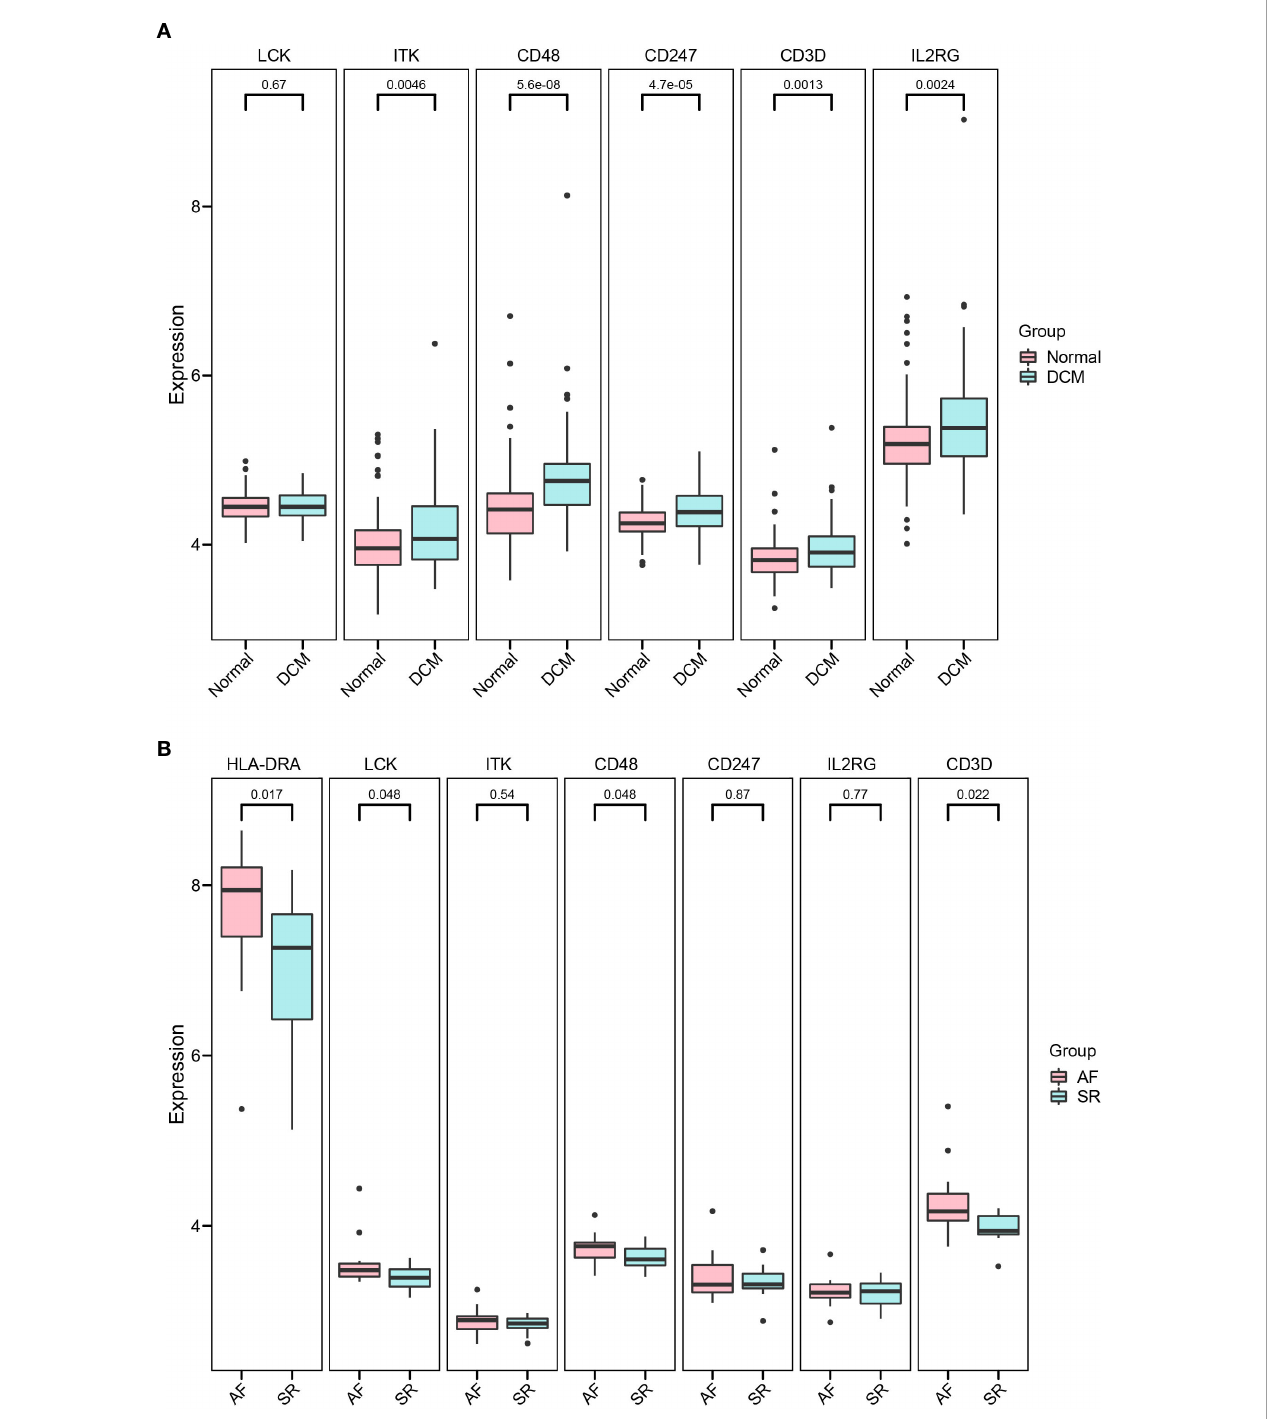
FIGURE 8 Validation of hub immune-related genes. (A, B) Detailed expressions of 7 hub immune-related genes were validated in datasets GSE57338 (DCM), GSE115574, and